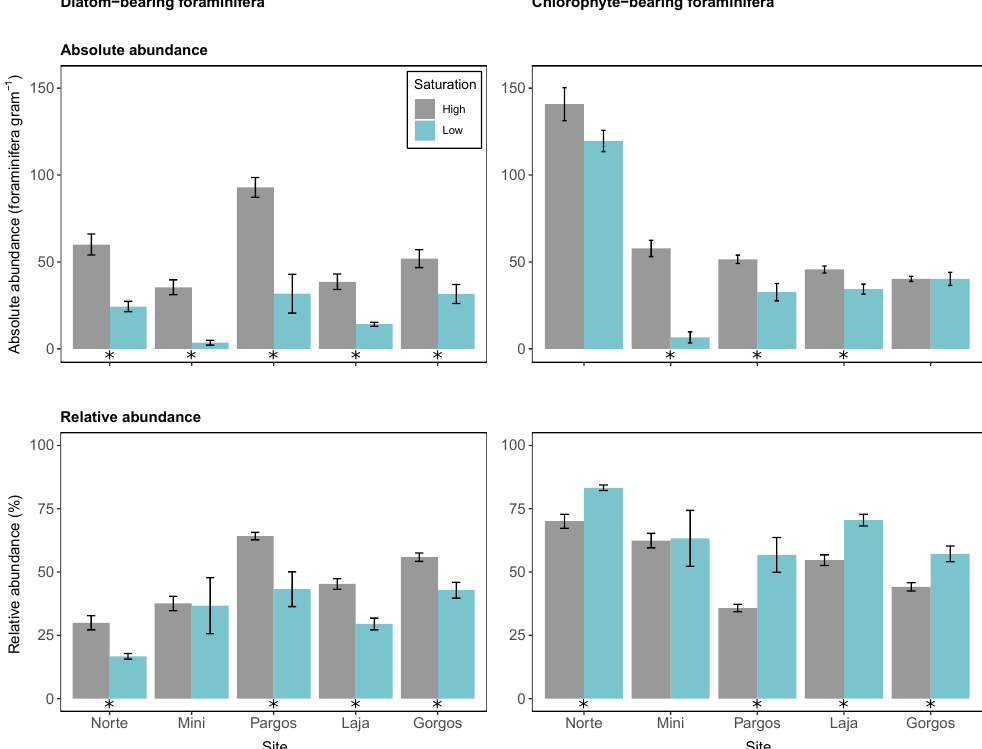
Figure 7. Absolute abundance (specimens per gram of sediment) and relative abundance (percentage) of large calcareous foraminifera that host different symbionts (diatoms and chlorophytes). Data are represented in mean ± SE ( n = 5). The asterisk demarks a significant difference ( p< 0 . 05) in abundance between paired springs and controls at each site, according to Mann–Whitney rank sum